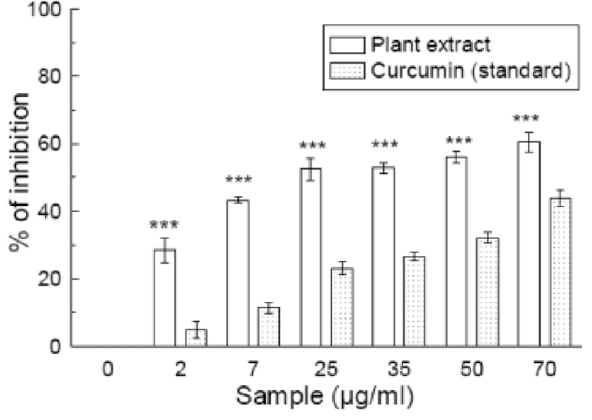
Nitric oxide radical scavenging assay . The nitric oxide radical scavenging activity of Spondias pinnata extract and the standard curcumin. The data represent the percentage